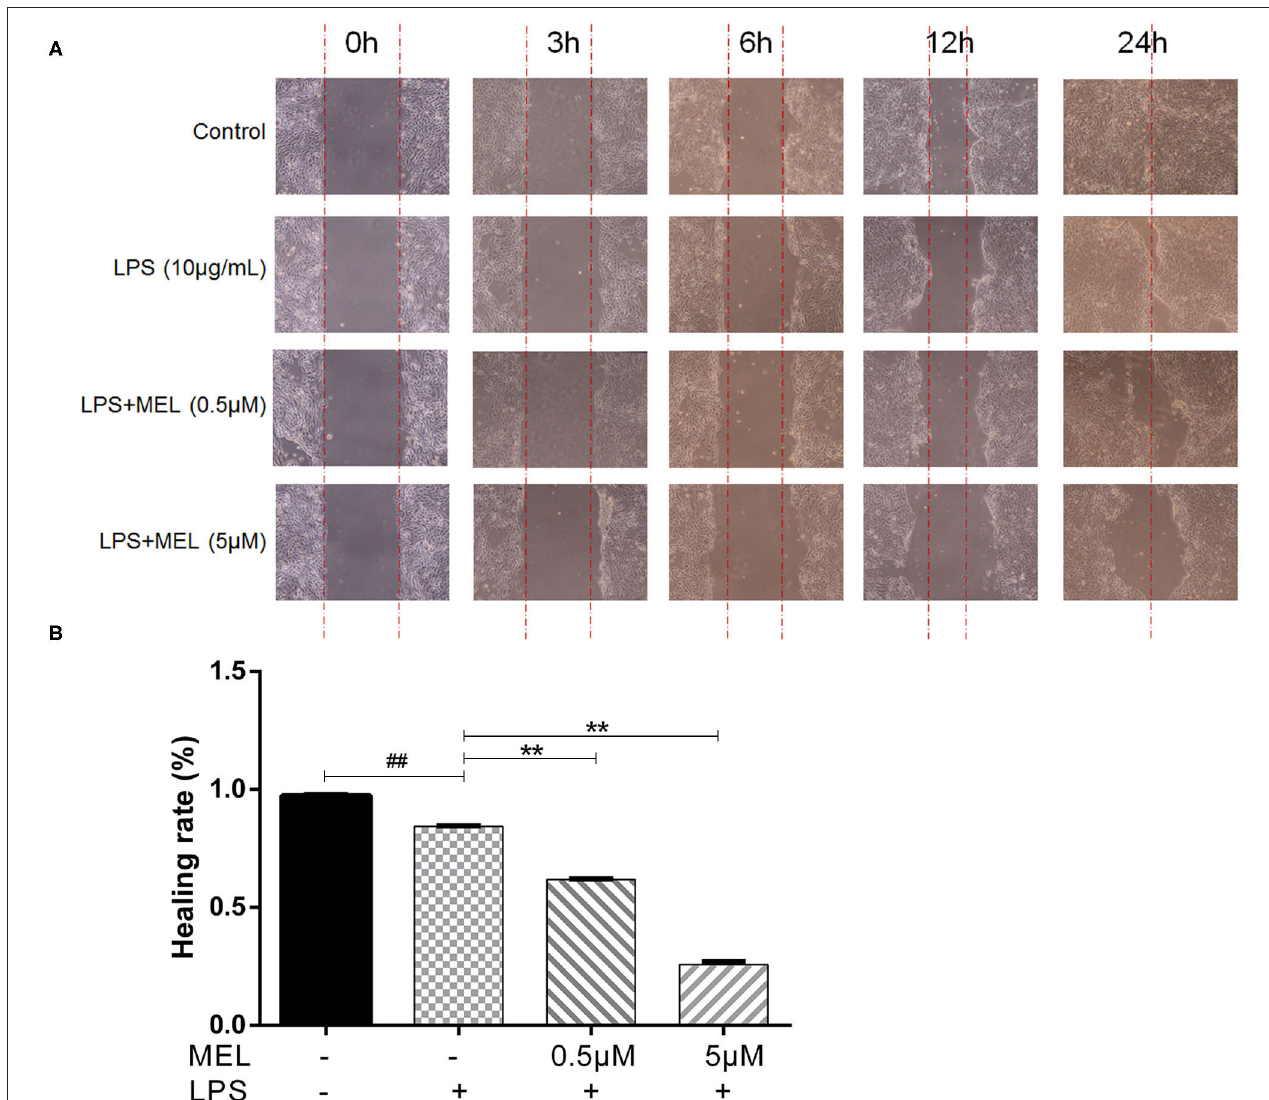
FIGURE 5 | The effect of meloxicam on the healing rate of lipopolysaccharide-stimulated bovine endometrial epithelial cells using the cell scratch test. LPS, lipopolysaccharide; MEL, meloxicam. (A) The cells were treated with LPS or co-treated with LPS and MEL (0.5 and 5 µ M) for 0, 3, 6, 12, and 24h to observe the cell healing under light microscopy at × 100 magnification. The parallel red dotted lines indicate the cell margins in the control group at each time point. (B) The healing rate of cells was detected at 24h using Image-Pro Plus software 6.0. Scratch width = scratch area/scratch length; Healing rate = (scratch width at 0h – scratch width at 24h)/scratch width at 0h × 100%. # P < 0.05, difference compared with the control; ## P < 0.01, difference compared with the control; * P < 0.05, difference compared with the LPS treatment group; ** P < 0.01, difference compared with the LPS treatment group. All data were presented as means ± SEM ( n =